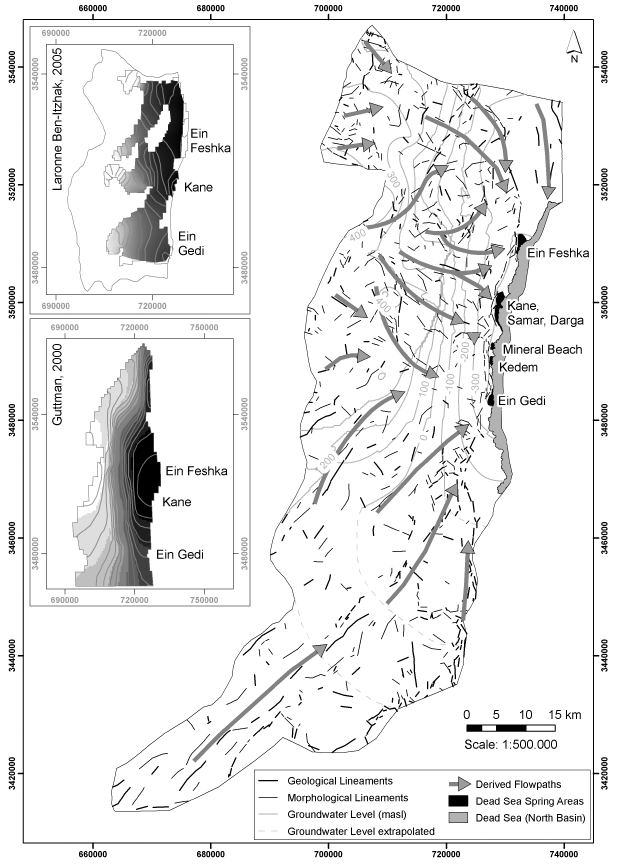
Fig. 7. Derived groundwater flow-paths based on lineament map, altitude and Dead Sea spring locations – for comparison the mod- elling results of (Guttman, 2000) and (Laronne Ben-Itzhak and Gvirtzman, 2005) and the groundwater level contour map are added (Groundwater level extrapolated refers to the insecurity of only three water wells in the southern area taken from Arad, 1966; Ven- gosh et al., 2007) (Projection: UTM WGS 84 Zone 36 ◦